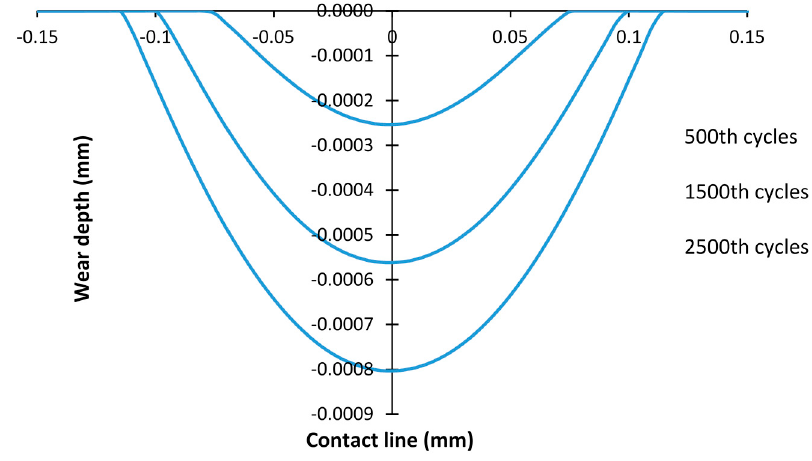
Figure 2. Wear scars of the specimen after different fretting wear cycles; P = 185 N and D = 25 µm.